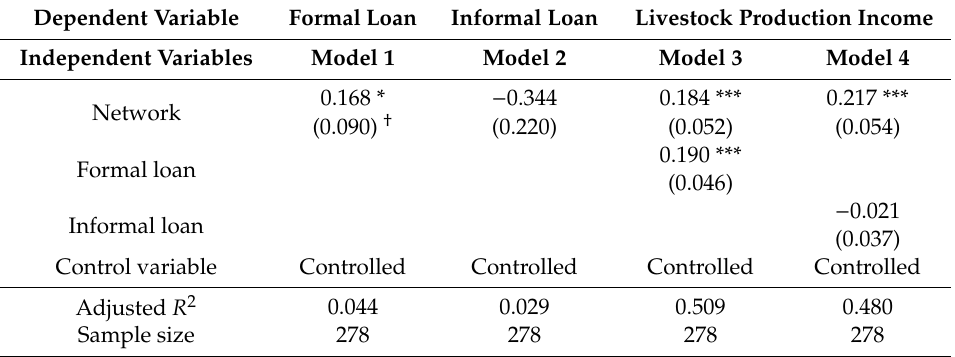
Table 9. Estimation results: the influence of the social network on household livestock production income through fund